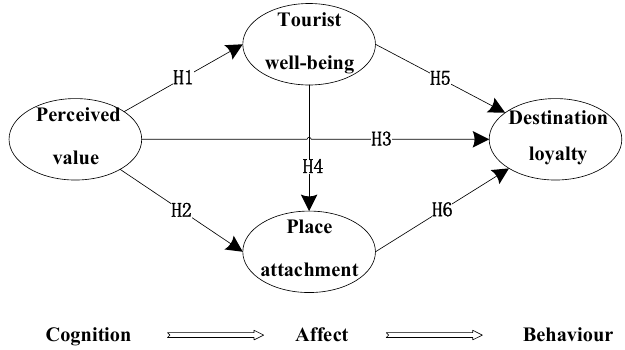
Figure 1. Initial conceptual model M 0